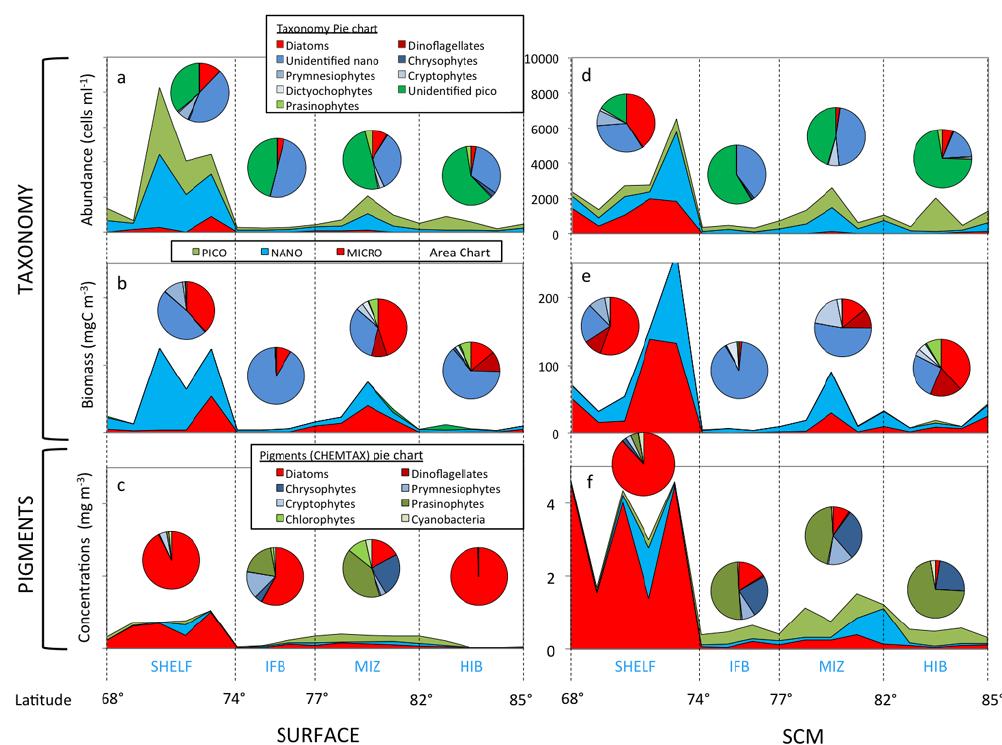
Fig. 6. Distribution of major groups of phytoplankton obtained by taxonomy (a, b, c, d) and pigments (e–f) in surface water (left panels) and in the SCM (right panels). Area charts show the abundance (a, b) and carbon biomass (c, d) of pico-, nano- and microplankton derived from taxonomy over the shelf, the ice-free basin (IFB), the marginal ice zone (MIZ) and heavy-ice basin (HIB). Area charts (e, f) show abundance of pico-, nano- and microplankton derived from pigment concentrations. Pie charts (a, b, c) and (d) show major phytoplankton groups derived from taxonomy counts. Pie charts (e) and (f) show the major phytoplankton groups calculated by the matrix factorization program